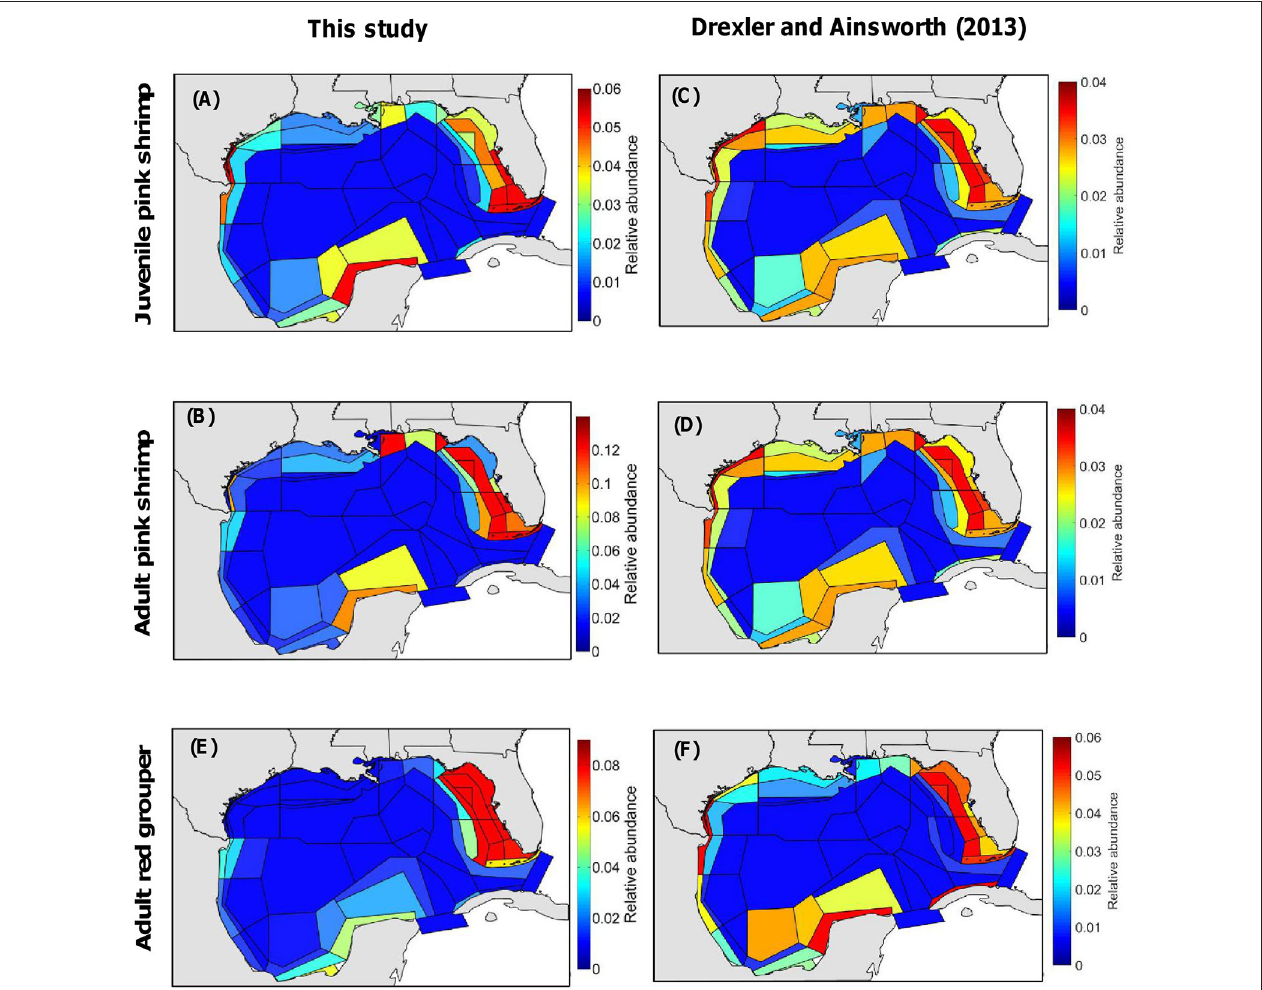
FIGURE 5 | Maps of relative abundance for the Atlantis-GOM ecosystem model (such that the sum of relative abundances for each map is equal to 1.0), produced (A–C,E) in the present study and (C,D,F) in Drexler and Ainsworth (2013). (A,C) are for juvenile pink shrimp ( Farfantepenaeus duorarum ), (B,D) are for adult pink shrimp, and (E,F) are for adult red grouper ( Epinephelus morio